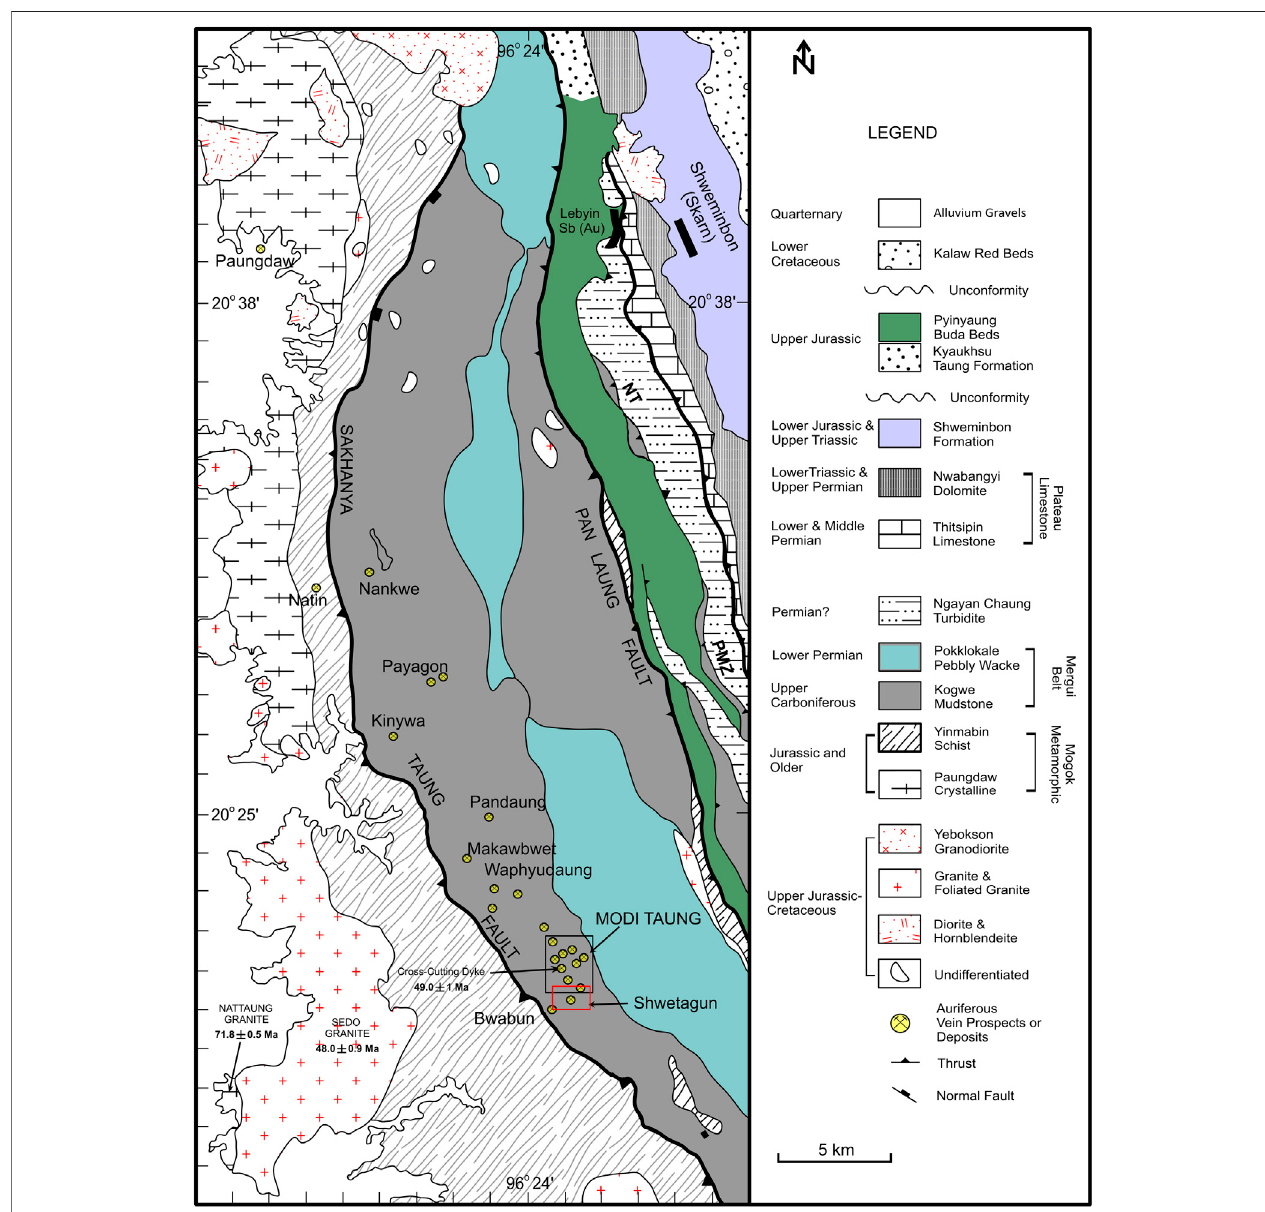
FIGURE 3 | Geological map of the Modi Taung-Nankwe gold district (Modi fi ed after Mitchell et al., 2004). NT, Ngapyaw Chaung Thrust; PMZ, Panlaung-Mawchi Zone.